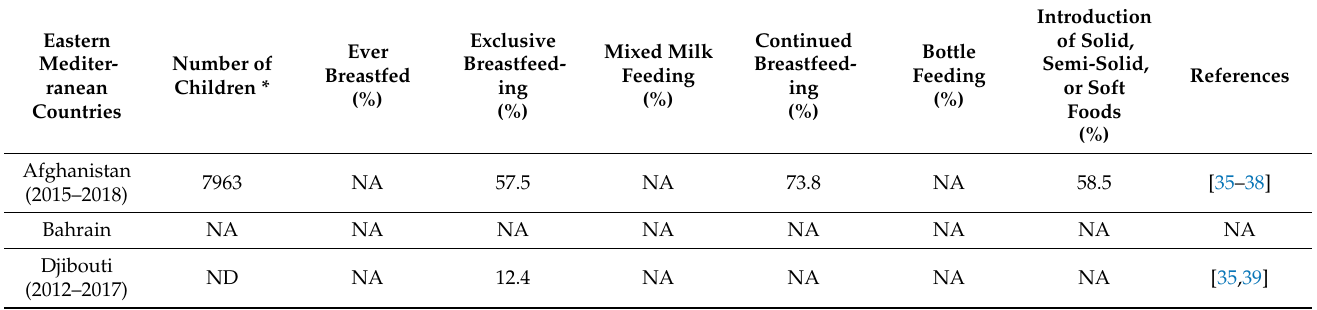
Table 1. Prevalence of infants and young children feeding patterns in the